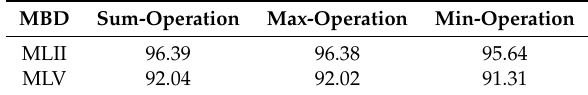
Table 2. Comparison of different operations in Minority-Based Dissimilarity